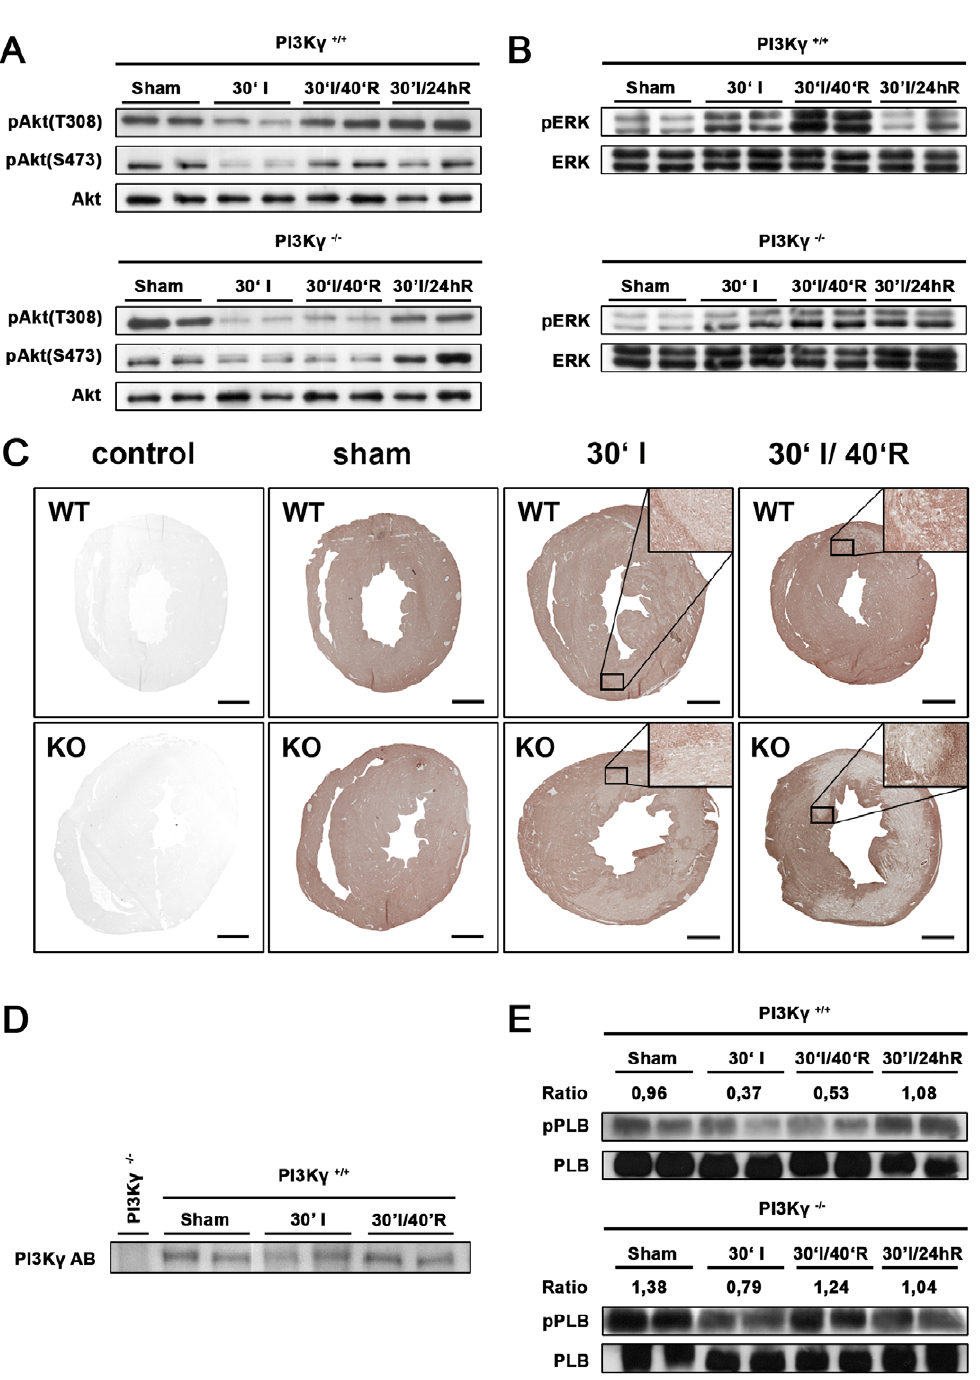
Figure 4. PI3K c is the critical mediatior of AKT and ERK1/2 activation in the acute phase of ischemia/reperfusion injury. ( A ) Western blot analysis of phosphorylated AKT (T308 and S473) and ( B ) phosphorylated ERK1/2 (T202/Y204) in PI3K c 2 / 2 and wild type PI3K c + / + hearts after sham surgery, 30 minutes of ischemia (30’I), 30 minutes of ischemia plus 40 minutes of reperfusion (30’I/40’R), and 30 minutes of ischemia plus 24 hrs of reperfusion (30’I/24hR). Total AKT and ERK1/2 levels are shown as controls. Representative data from 2 mice for each genotype and treatment protocol are shown. ( C ) Immunohistochemical staining for phosphorylated AKT (S473) in PI3K c 2 / 2 (KO) and wild type (WT) hearts after sham surgery (left panels), 30 minutes of ischemia (30’I), and 30 minutes of ischemia plus 40 minutes of reperfusion (30’I/40’R). A secondary antibody staining control is shown (control). Bar indicates 1 mm. Inserts are 20 6 magnifications. ( D ) Western blot analysis of wild type hearts to determine PI3K c expression levels in sham-treated mice, 30 minutes of ischemia (30’I), and 30 minutes of ischemia plus 40 minutes of reperfusion (30’I/40’R). Representative data from 2 mice for each genotype and treatment protocol are shown. Heart lysates from PI3K c 2 / 2 mice are shown as a specificity control. ( E ) Increased phosphorylated phospholamban B (pPLB)/phospholamban B (PLB) ratios in hearts from PI3K c 2 / 2 mice compared to wild type mice after sham surgery, 30 minutes of ischemia (30’I), 30 minutes of ischemia plus 40 minutes of reperfusion (30’I/40’R), and 30 minutes of ischemia plus 24 hrs of reperfusion (30’I/24hR). Western blot results are shown as duplicates. For all Western blots, the area at risk was dissected from the left ventricle.